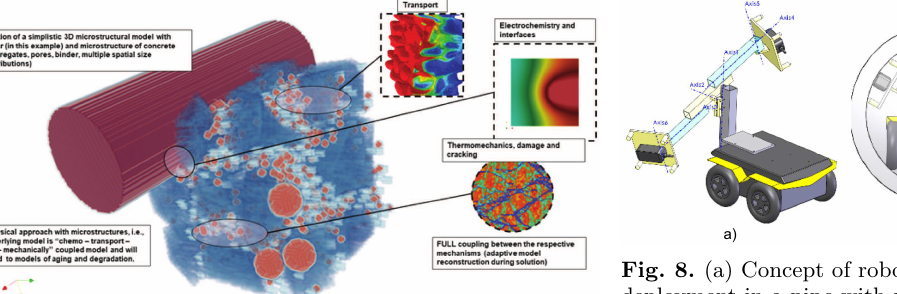
Fig. 7. Phenomenological modelling concept of steel corrosion.